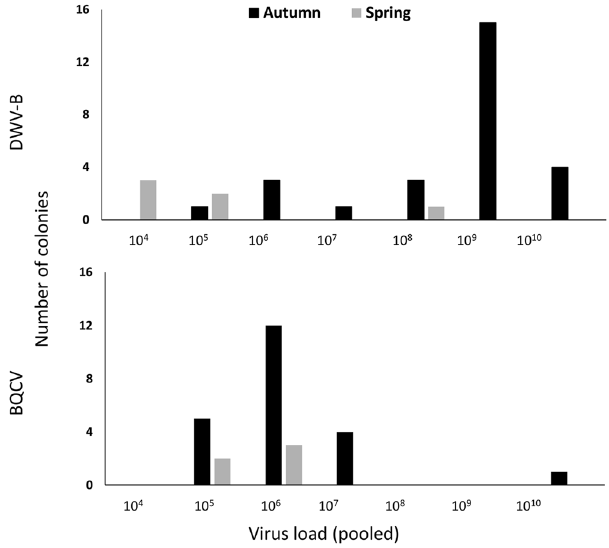
Figure 2. Histogram of DWV-B and BQCV viral titre in pooled colony samples (N = 30 bees per colony). Values represent average titre per bee. Black: viral titres in autumn; grey: viral titres in